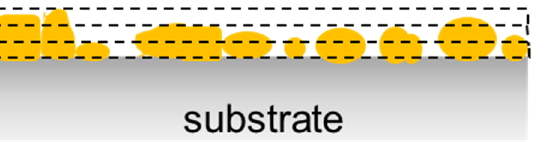
Figure 6. Conceptual picture of the GNP electrode layer and its division in three virtual layers of increasing Au volume from top to bottom.